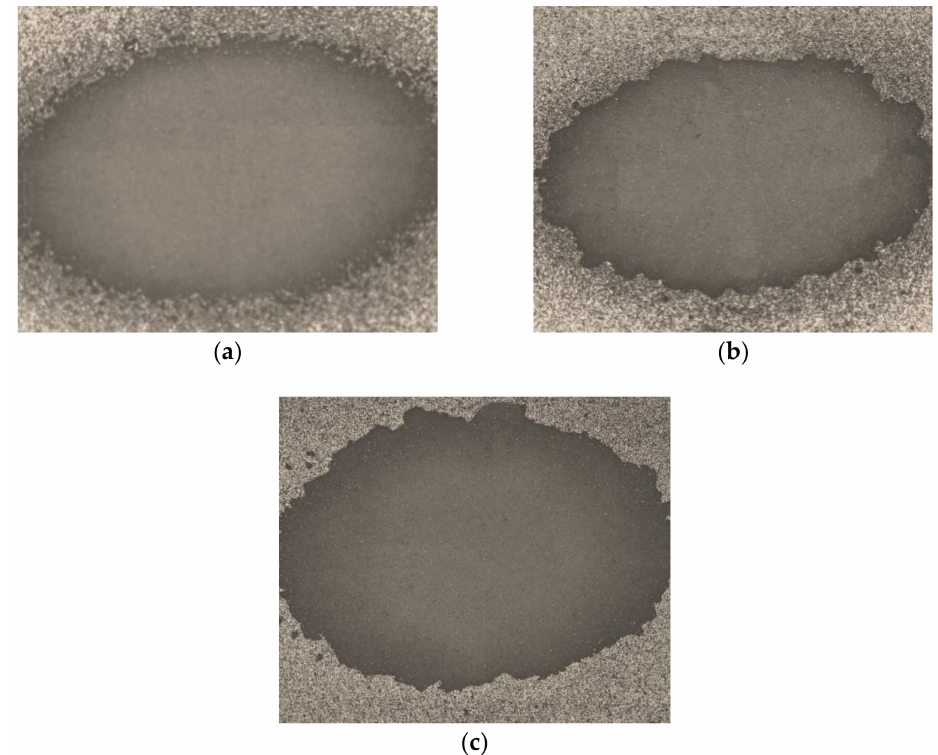
Figure 11. Images ( × 250) of wear craters (holes) on the surface of the samples of Al 2 O 3 + SiC ceramic with various coatings after exposure to the air-abrasive flow: ( a ) TiZrN coating; ( b ) DLC; ( c ) TiCrAlN